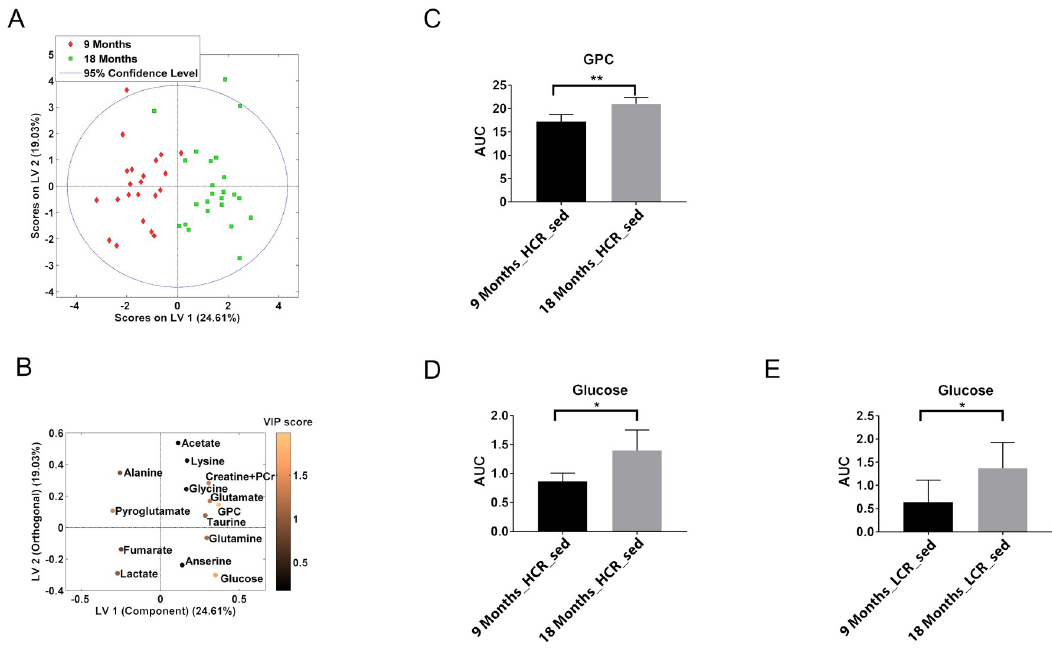
Fig 5. Multivariate and univariate analysis of metabolic profile of 9 months old rats compared to 18 months old rats. ( A ) The score plot of PLS-DA separated 9-month from 18-month (permutation test, P = 0.001). ( B ) Loading variables 1 (LV1) and LV2 display the contribution of the individual metabolites to the model. Contribution of each metabolite to the model is illustrated by colour, where a lighter shade indicates a greater VIP score and greater contribution to the model. ( C ) Pairwise comparison between 9 months HCR sed and 18 months HCR sed of glycerophosphocholine (GPC). ( D and E ) Pairwise comparison of glucose between 9 months HCR sed and 18 months HCR sed ( D ) and between 9 months LCR sed and 18 months LCR sed ( E ). P values: � , < 0.05; �� , < 0.01.